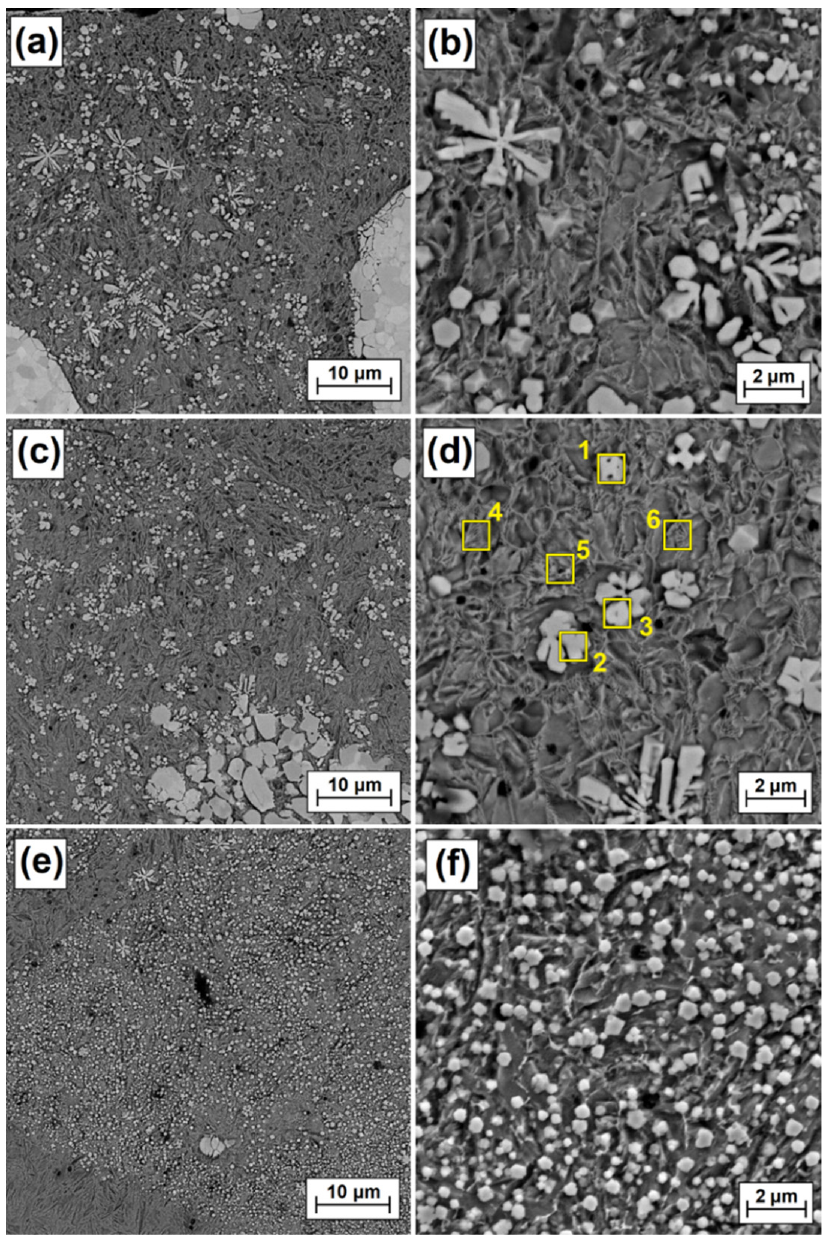
Figure 7. Melted zone microstructure of Fe/ZrC coatings produced using laser beam power of 700 W; subsurface area ( a ), magnification of subsurface area ( b ), middle area ( c ), magnification of middle area ( d ), sub-substrate area ( e ), magnification sub-substrate area ( f ) .